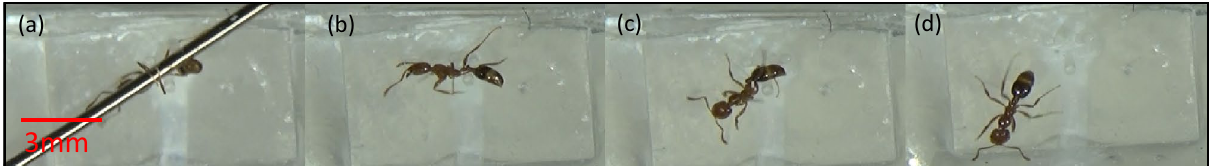
Figure. 11. Manipulation of a live insect. ( a ) Start the grabbing of the ant. A needle is used to hold the insect on the top of the gripper. ( b ) Successful handling of a live ant by using a square-shaped device. ( c ) Opening the gripper to release the ant. ( d ) Ant left the gripper without any